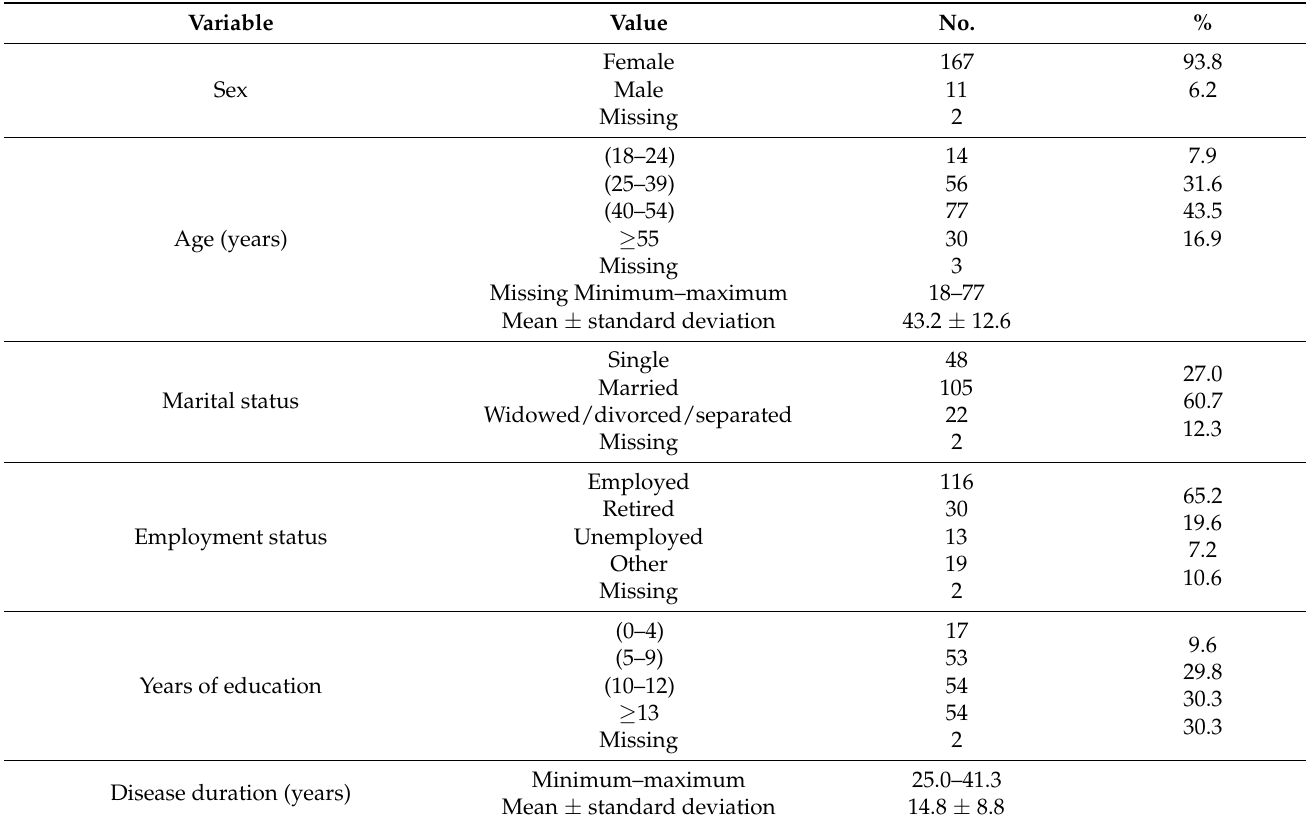
Table 1. Sample demographic and clinical characteristics (n =